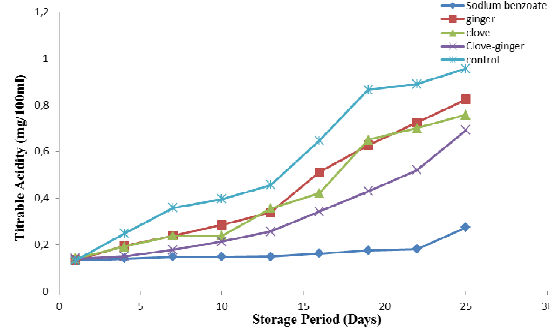
Fig. 17. Effects of various treatments on the titrable acidity of soymilk samples at 3% concentration stored at refrigerated temperature for 25 days